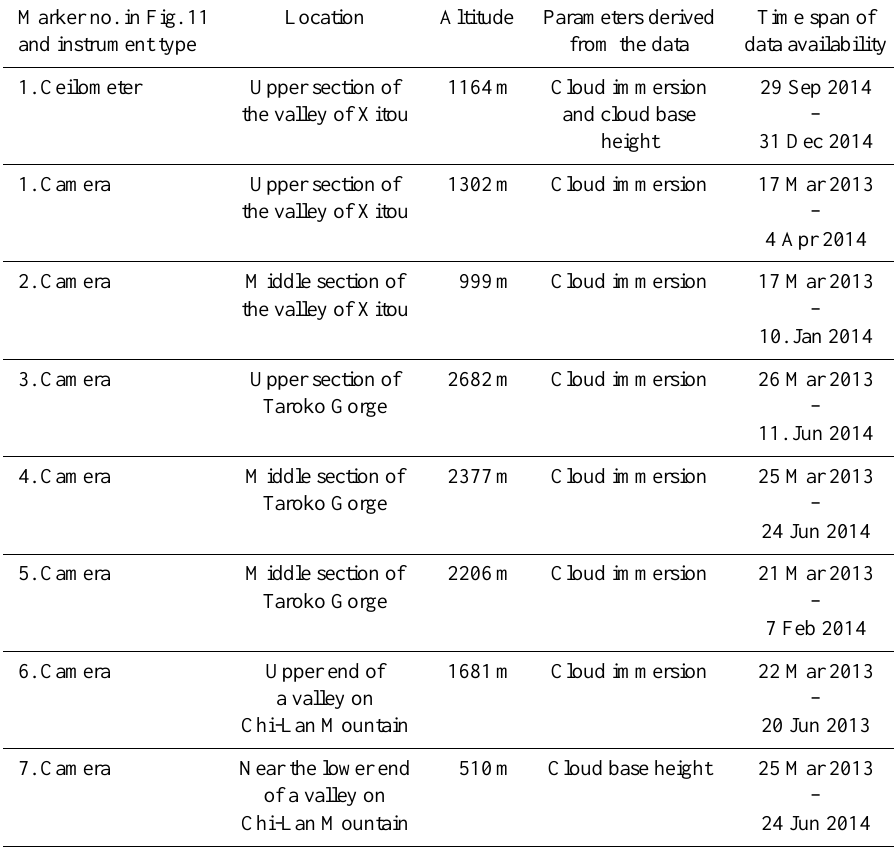
Table 4. Overview of the instruments used for the validation study. Marker no. in Fig. 11 and instrument